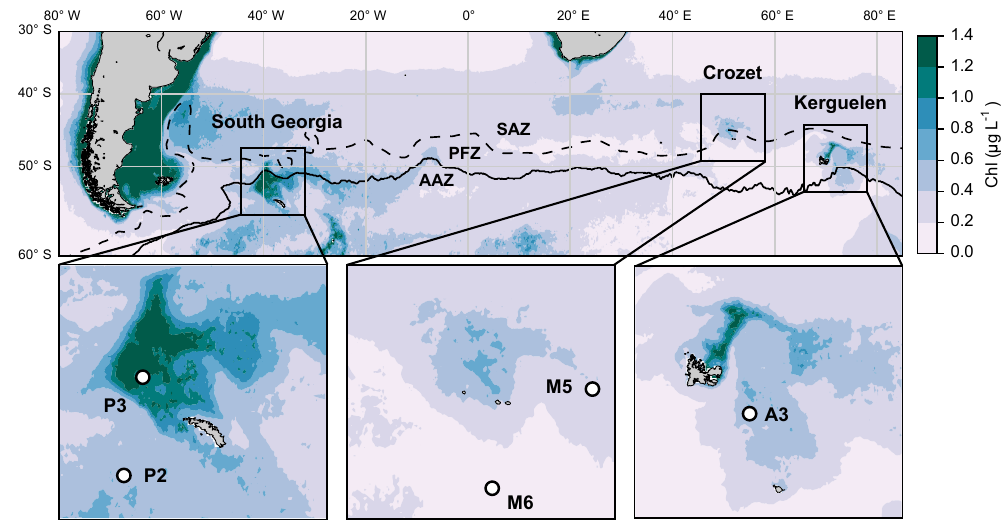
Figure 1. Location of the five annual sediment trap deployments in the Southern Ocean. Colours show annual surface satellite-derived chlorophyll a climatology (MODIS 2002–2016 full mission product accessed at http://oceancolor.gsfc.nasa.gov/cms/, last access: 16 Septem- ber 2014). Dashed and continuous lines represent respectively the Subantarctic Front (SAF) and polar front (PF) from Sallée et al. (2008).